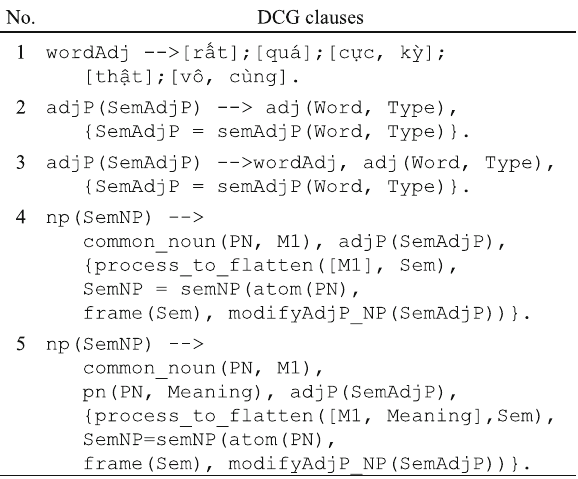
Table 6 DCG clauses express the semantic of an adjective